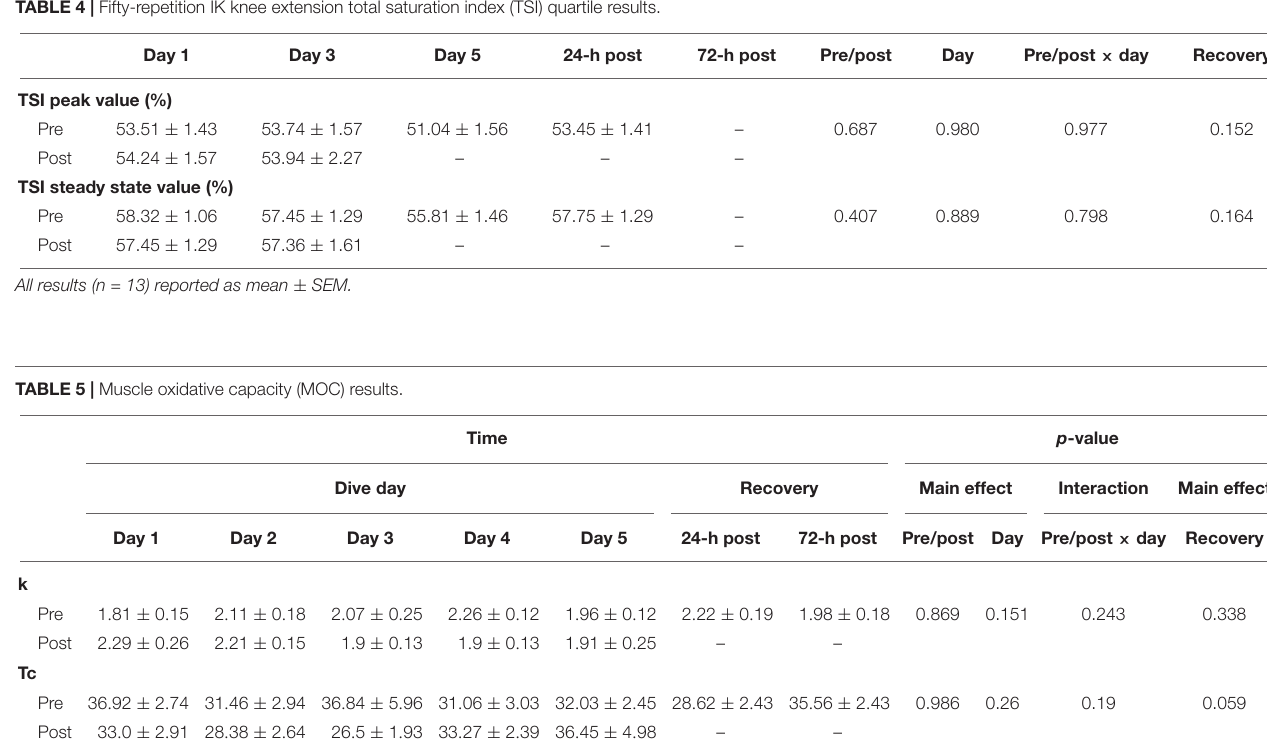
TABLE 4 | Fifty-repetition IK knee extension total saturation index (TSI) quartile results.